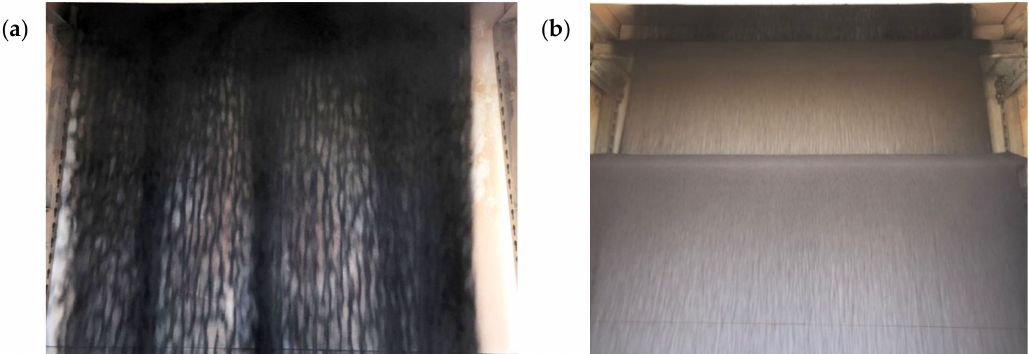
Figure 6. Photos of a free-falling curtain ( a ) and with a StAIR design using two hybrid troughs [75] ( b ). Lagrangian/Eulerian/DO models of the StAIR design were used evaluate the